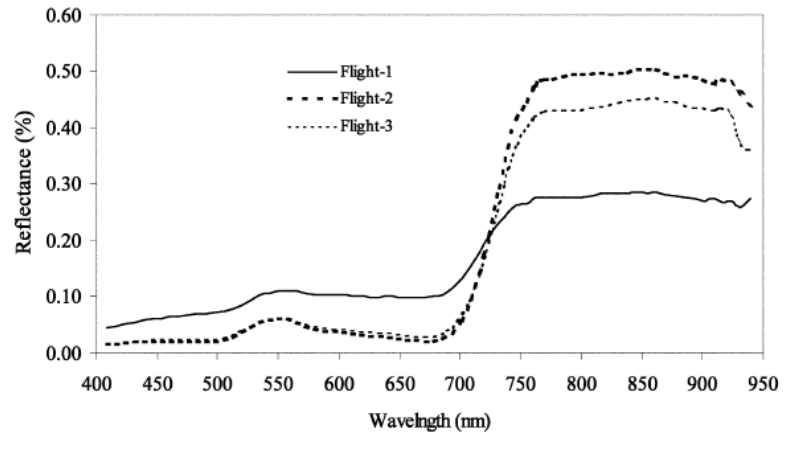
Figure 2. Reflectance (%) of the corn response during different flights under normal nitrogen rates and no weed control [21], Copyright Elsevier, 2003.